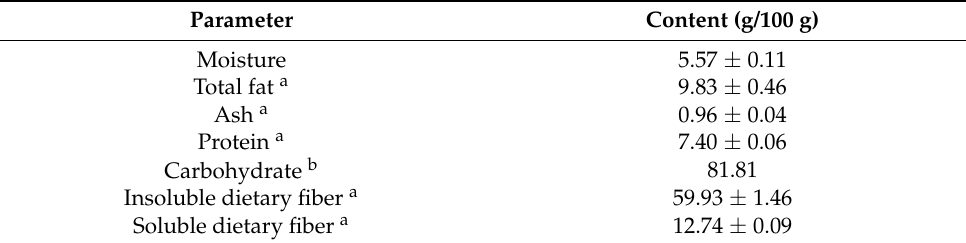
Table 1. Chemical composition of cranberry pomace.